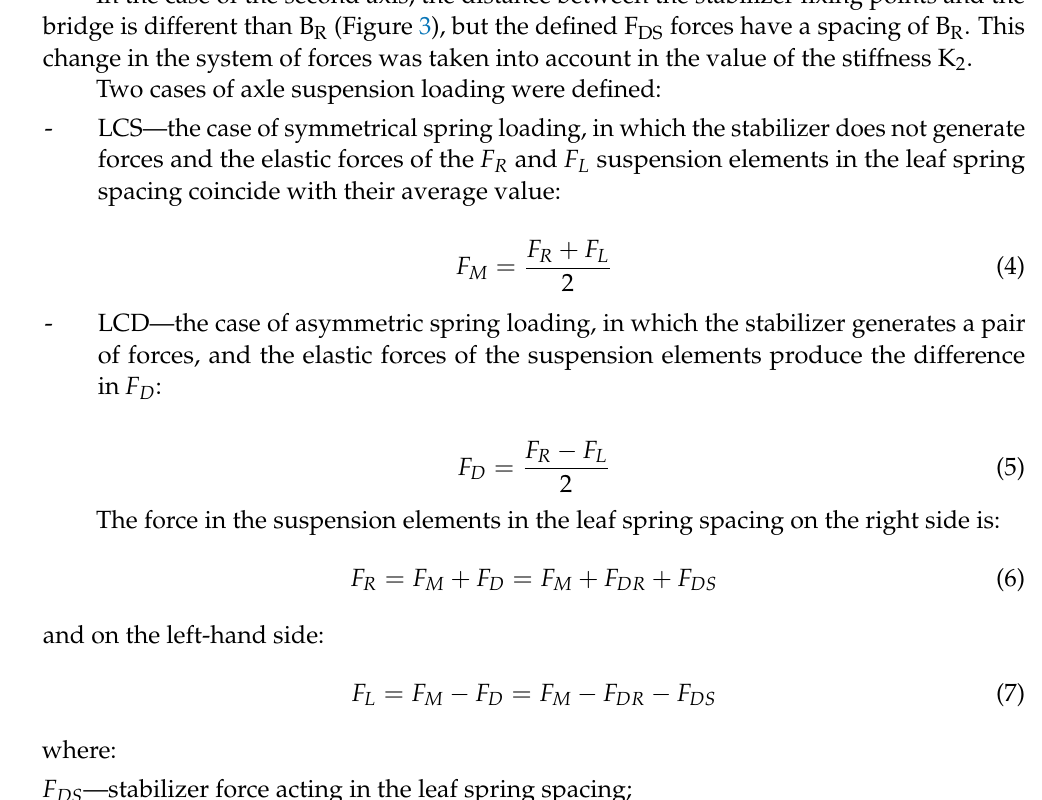
Figure 11. Fatigue curves of 51 CrV4 steel for R = 0 and the characteristic (red) adopted based on the performed tests (red).